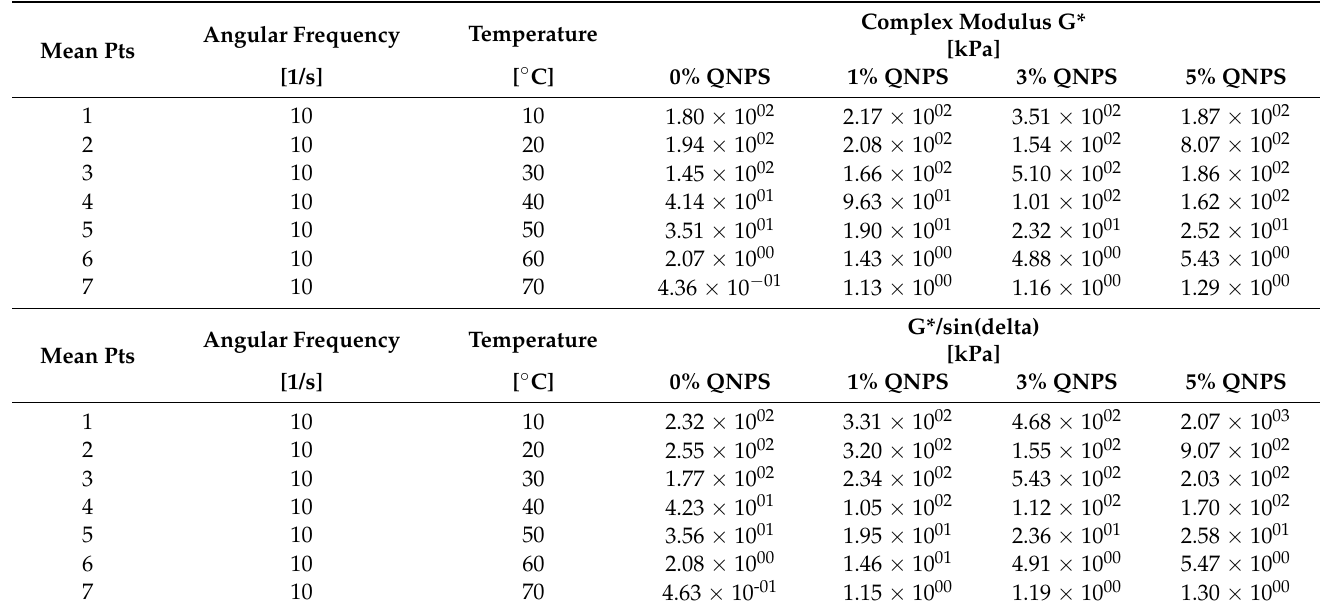
Table 7. Influence of temperature on G* and G*/sin δ at an angular frequency of 10 (1/s).